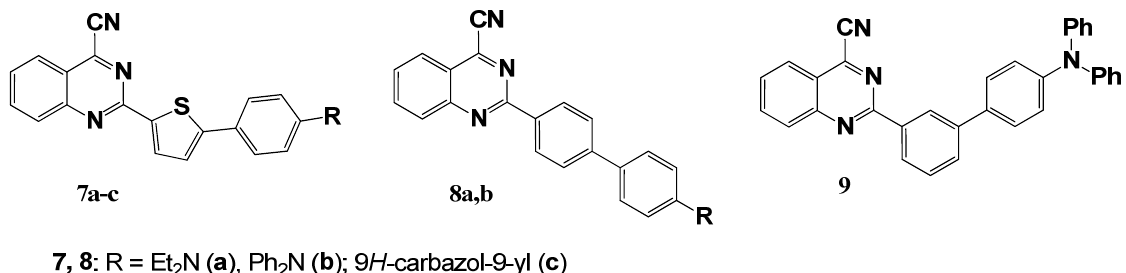
Figure 2. Structure of 2-aryl/thienyl-4-cyanoquinazolines 7 – 9 .